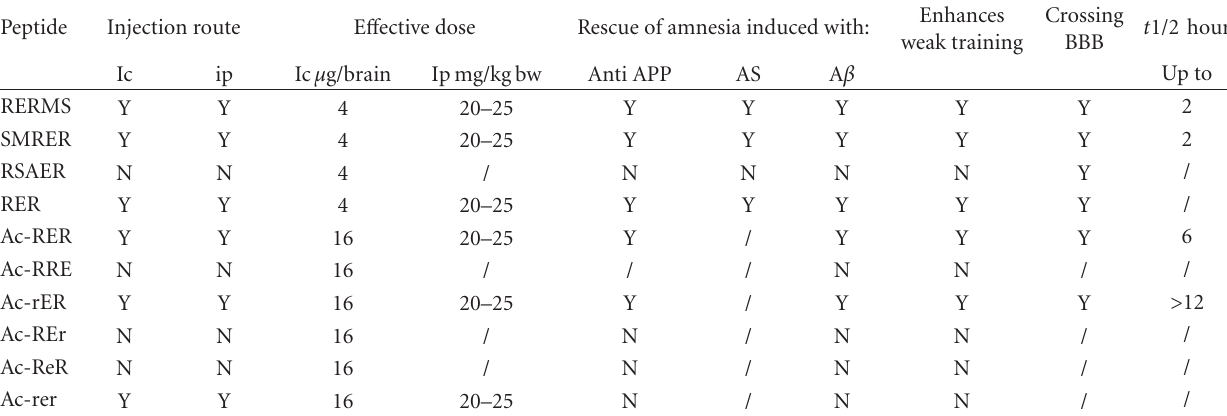
Table 3: Summary of peptides and their e ff ects on memory reported in this study.